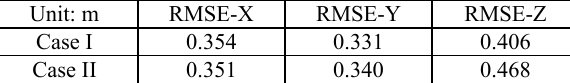
Table 1. Comparison results of relative